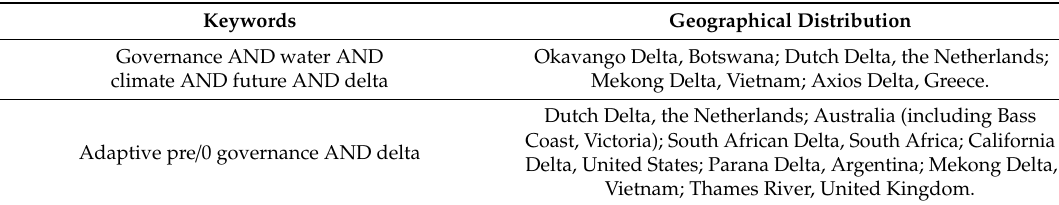
Figure 2. Number of delta cases documented in the literature, specified per delta. Table 1. Geographical distribution of literature findings based on